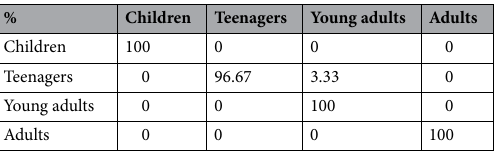
Table 3. Confusion matrix of percentage classification in age